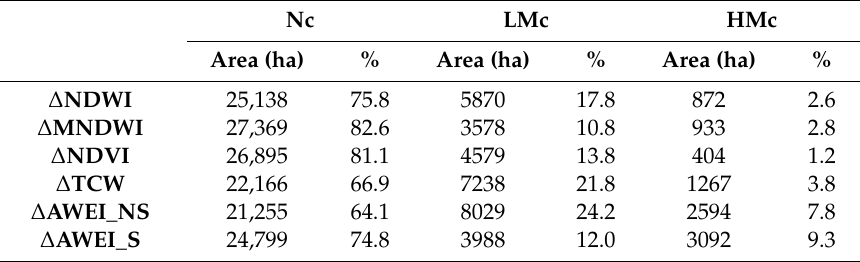
Table 7. Coeval class results, obtained within the ROI from each ∆ WrI, for the 2003 flood event. Nc